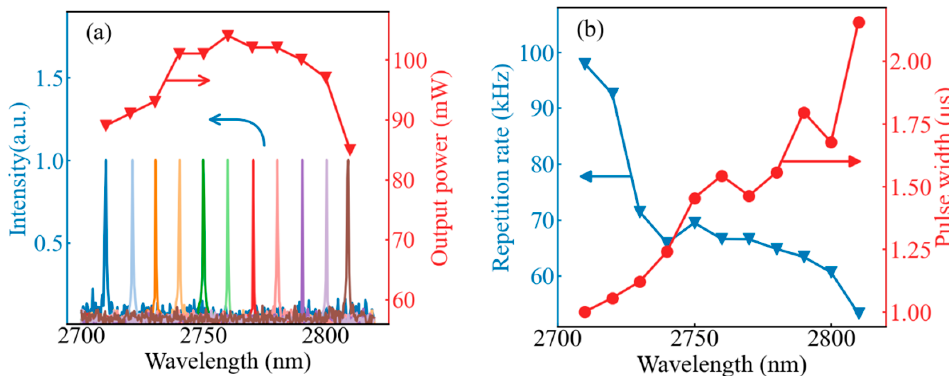
Figure 6. ( a ) Output spectrum (colored lines) and output power (triangle) as a function of wavelength at a pump power of 1.4 W. ( b ) Repetition rate (triangle) and pulse width (circle) as a function of wavelength at a pump power of 1.4 W.